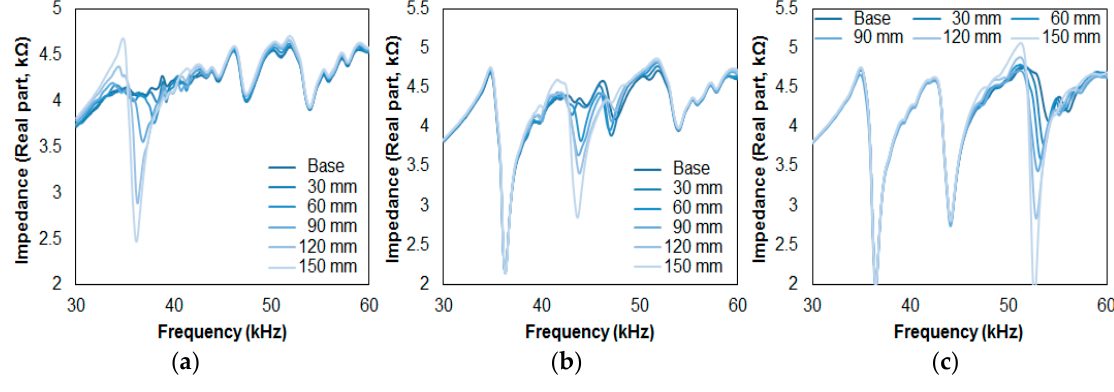
Figure 6. Impedance signature results for: ( a ) Case 4; ( b ) Case 5; ( c ) Case 6.